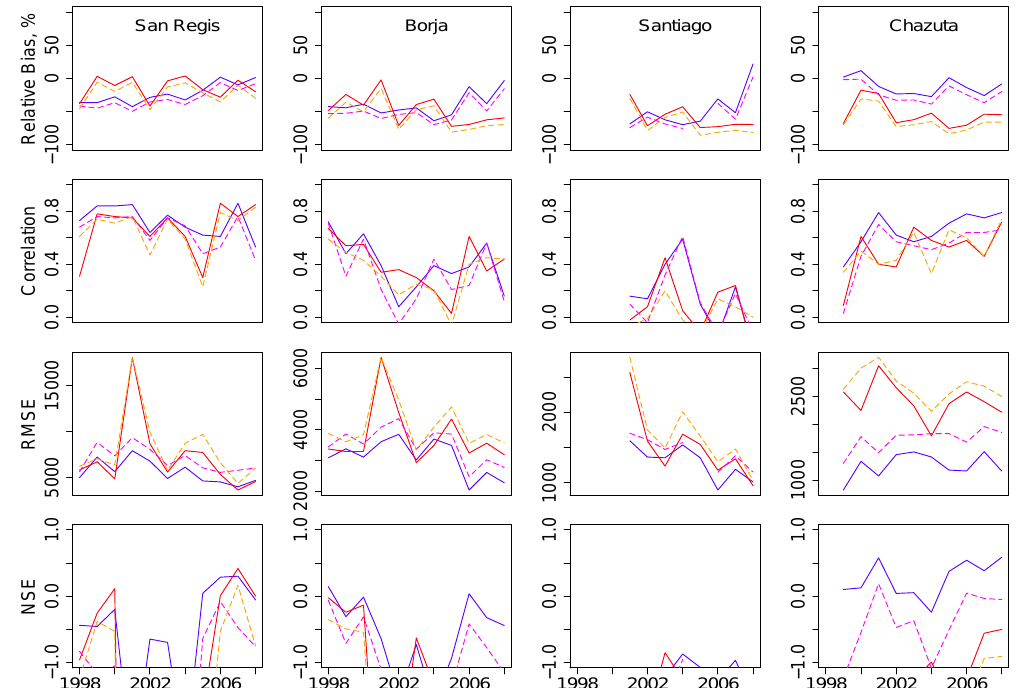
Fig. 4. Temporal and spatial trends in the hydrological performance indices. Blue: JULES-BASE and TRMM, magenta: JULES-TOPMODEL and TRMM, red: JULES-BASE and NCEP, orange: JULES-TOPMODEL and NCEP.